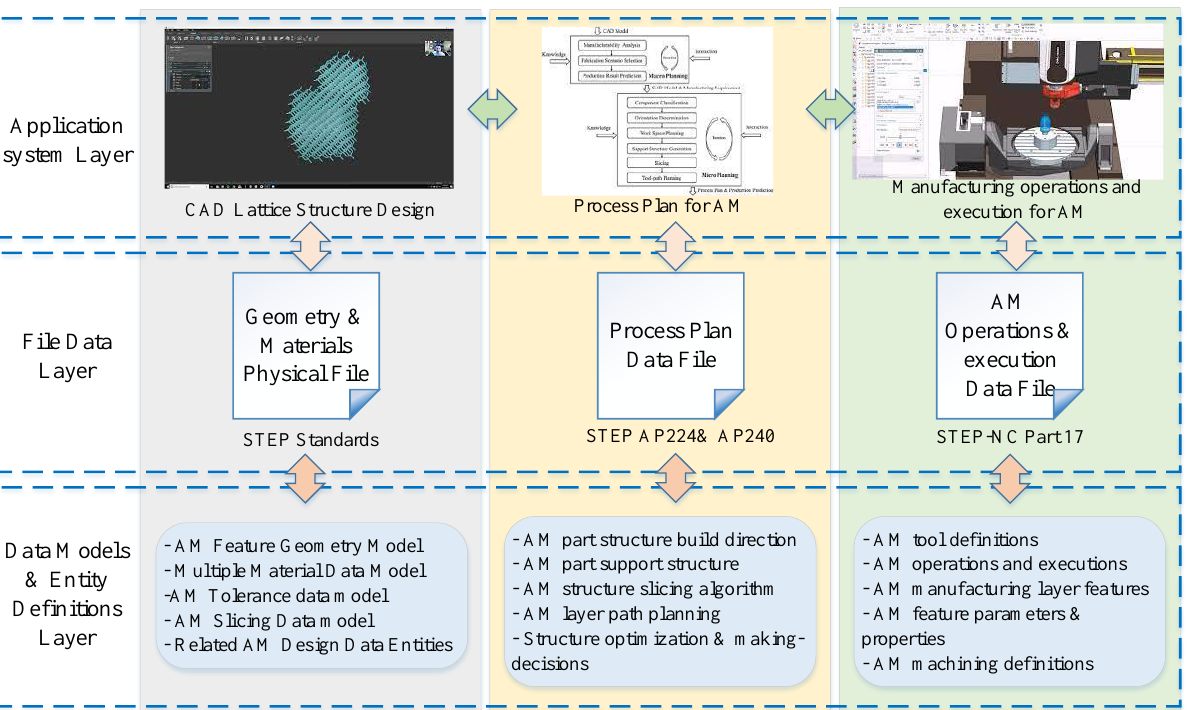
Figure 1. AM design and manufacturing information architecture based on various data layers.